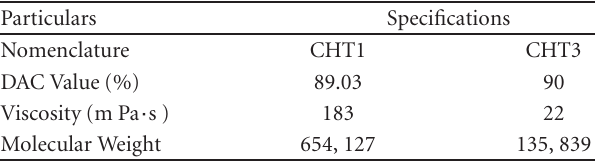
Table 1: Specifications of di ff erent